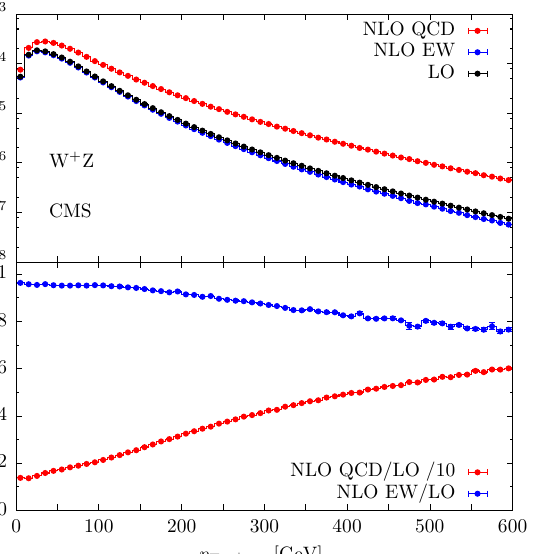
or invariant masses the differential distributions are strongly suppressed by the NLO QCD